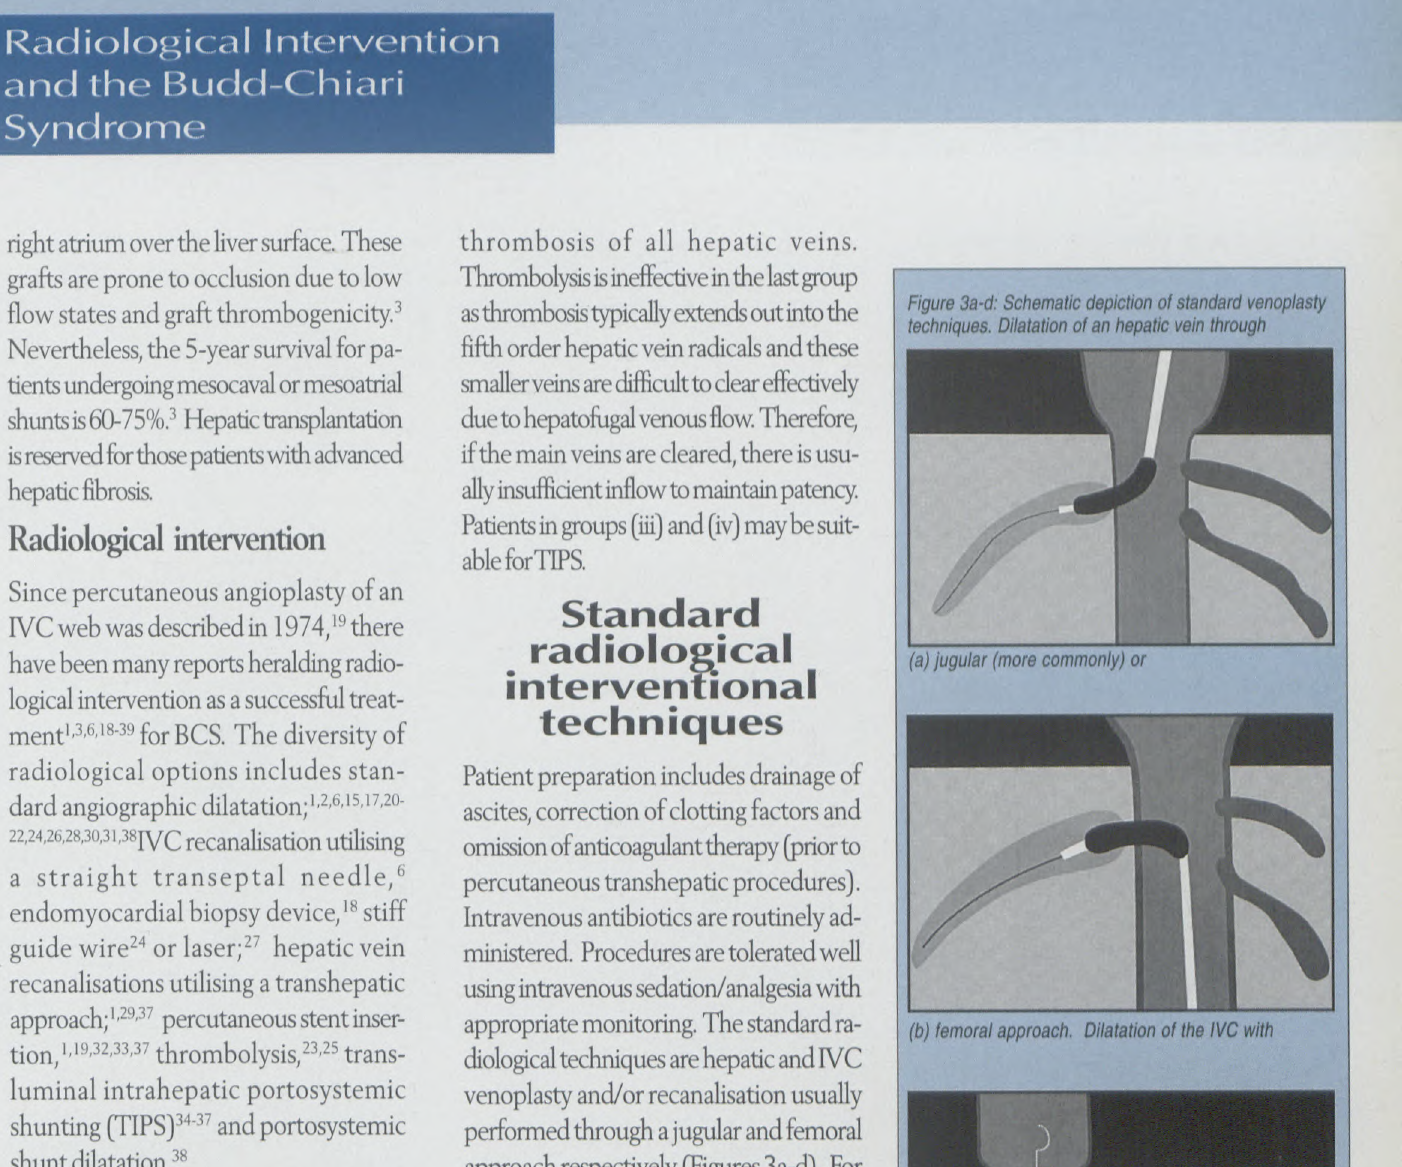
thrombosis of all hepatic